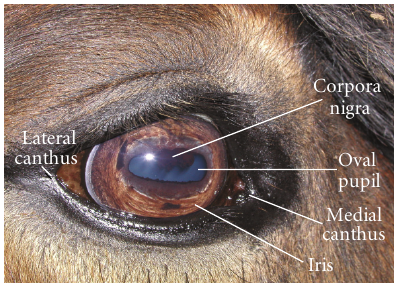
Figure 2: External features of the equine eye (right eye), including the horizontal pupil, corpora nigra, lateral and medial canthus (angle at either end of the eyelid aperture), and